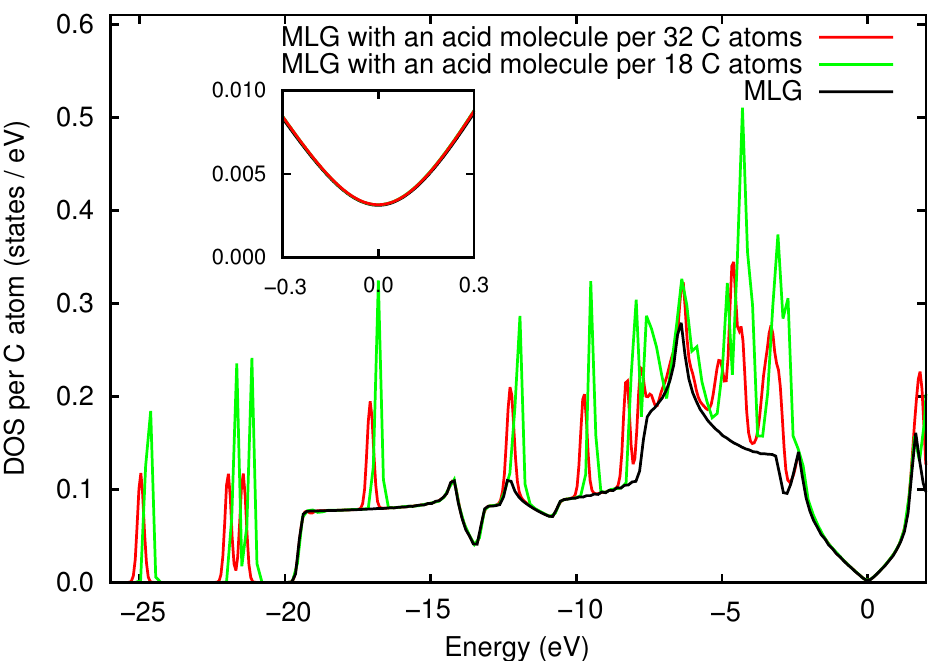
Figure 5. Densities of states per C atom of a monolayer graphene with a chlorosulfonic acid molecule adsorbed per 18 (green line) and 32 carbon atoms (red line). The DOS per C atom of MLG (black line) is given as a reference. The Fermi energy has been used as energy origin.